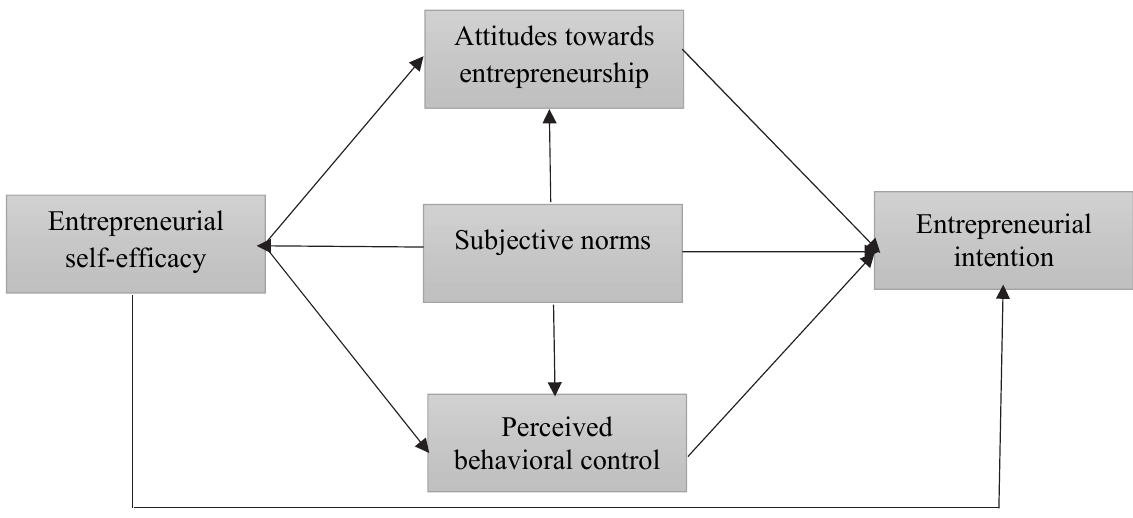
Fig. 1. Conceptual